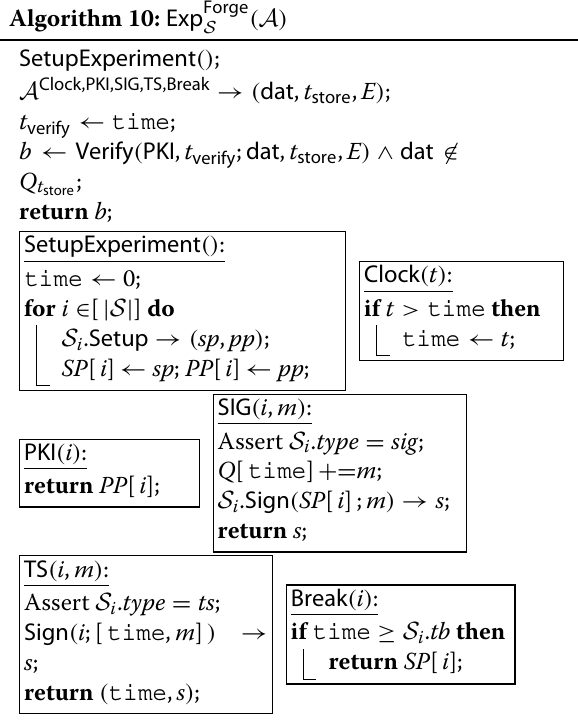
Algorithm 10: Exp Forge